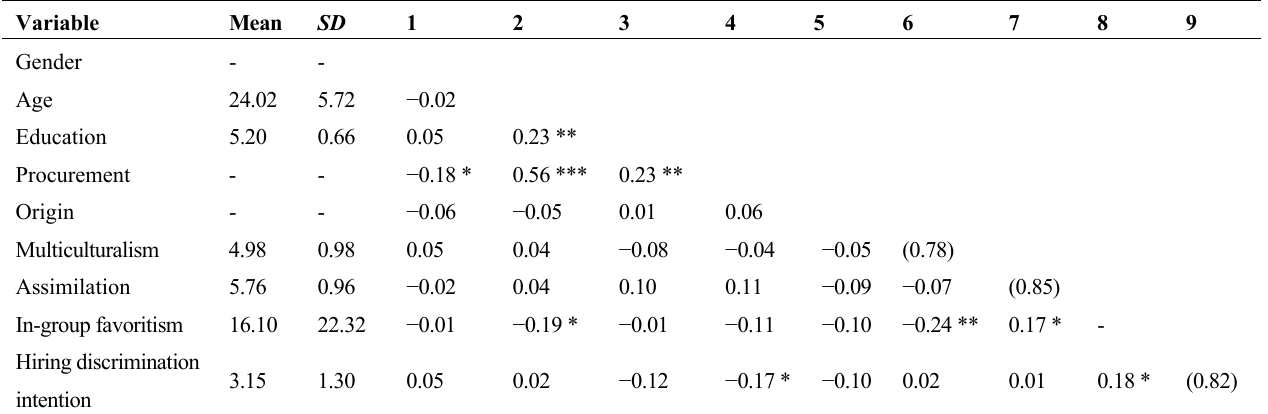
Table 2. Descriptive statistics and simple intercorrelations among